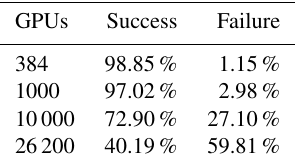
Table 5. Success and failure rates of different scales for 1 wall clock hour